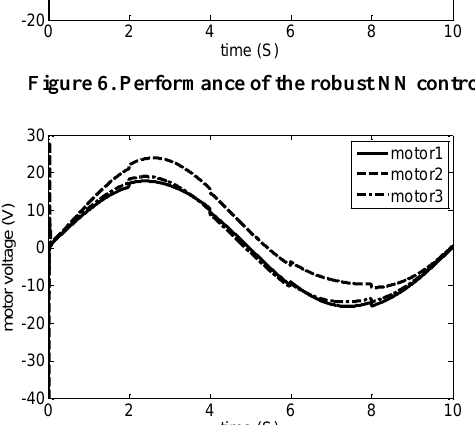
Figure 4. Adaptation of parameters.